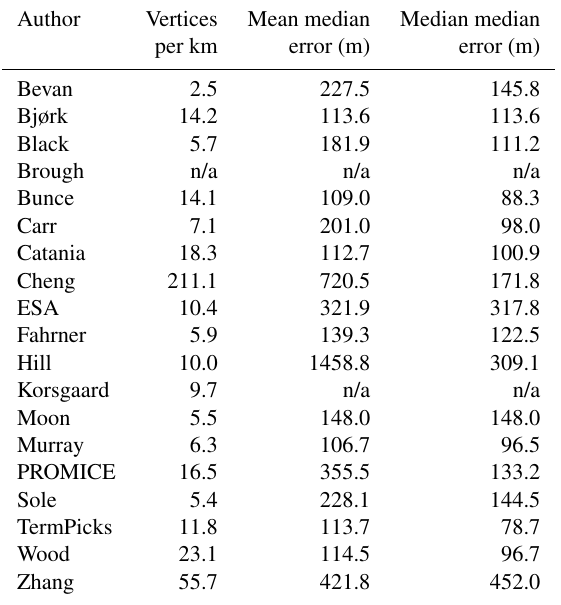
Table 4. Mean vertices per kilometer of trace, as well as mean and median of the median errors of each author compared to other au- thors. n/a – not